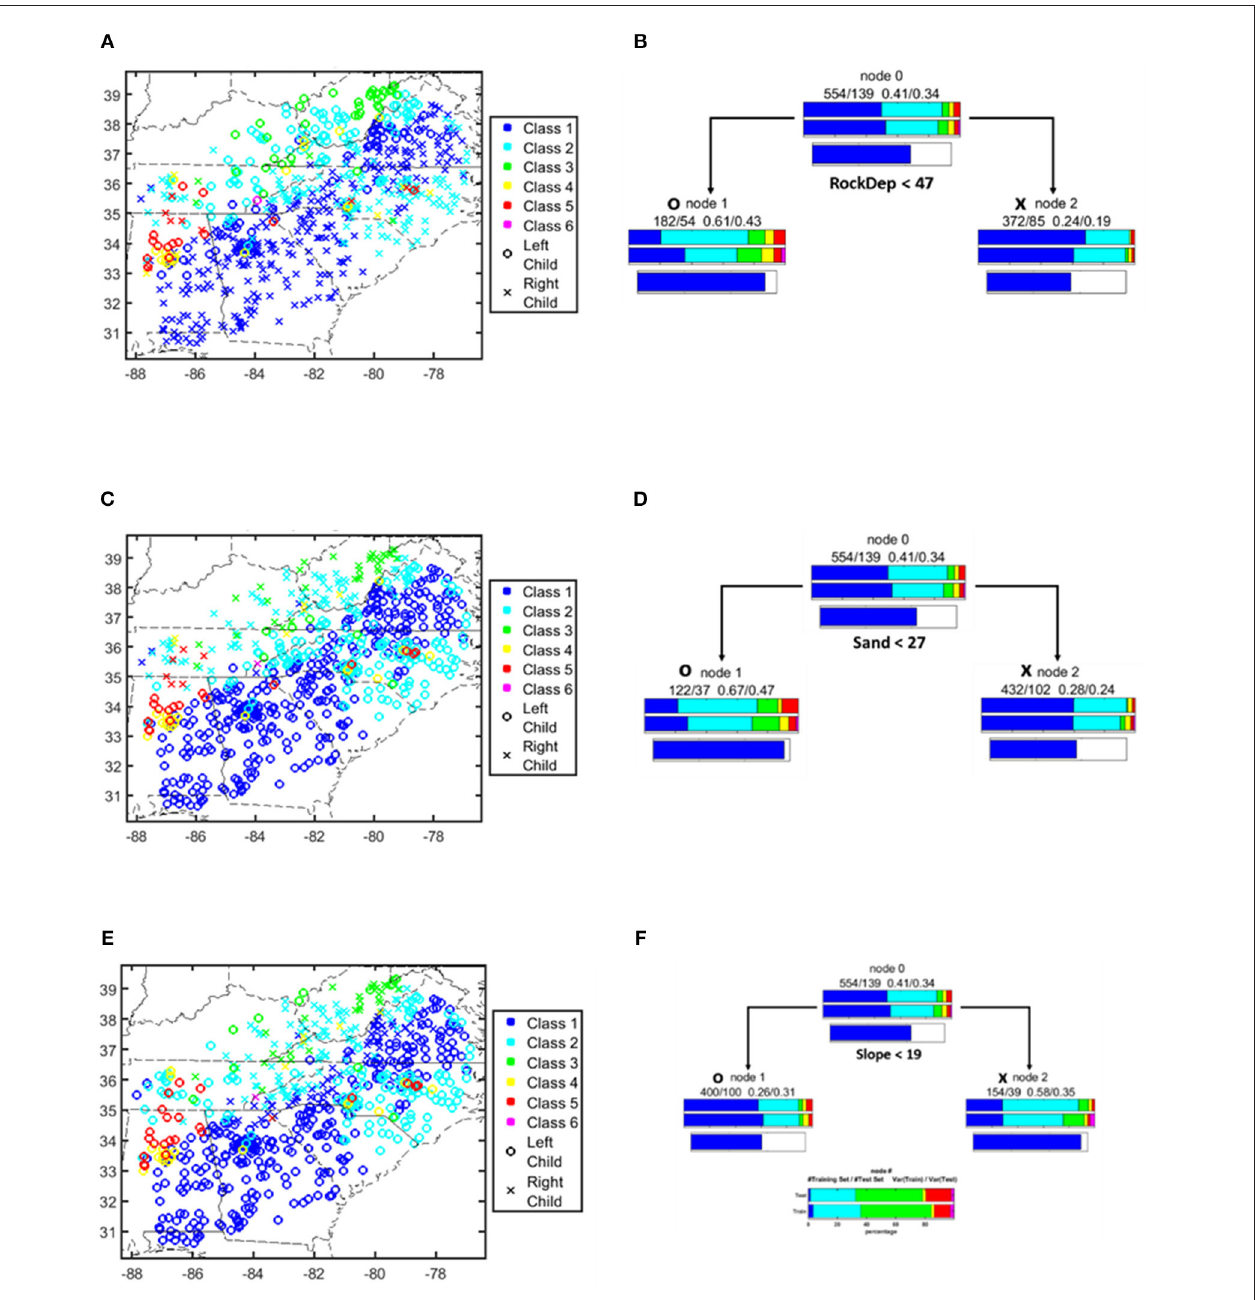
FIGURE 4 | A one-level classification tree model picks up soil thickness (RockDep) as the main difference between two types of storage-stream flow correlation patterns compared to other physical factors like soil texture (result for sand percentage shown here, Sand) and terrain (Slope) (Reproduced from FS17 with permission). (A,C,E) Southeastern region of CONUS. Color indicates SSCS class, symbols indicate tree nodes for physical factor (RockDep, Sand, Slope). (B,D,F) One-level ad hoc trees to predict class #1 in (A,C,E) via physical factor (RockDep, Sand,